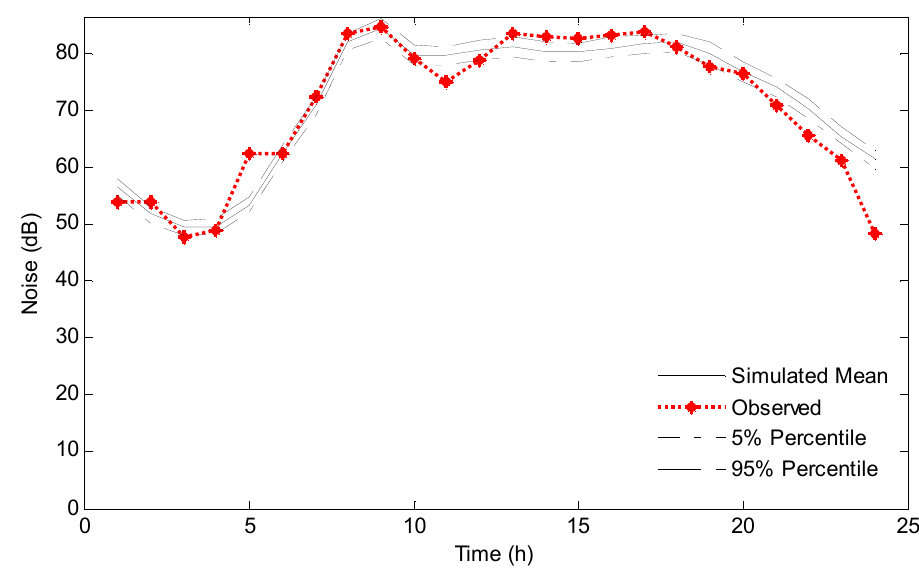
Figure 6. Comparison between the predictions and observations in scenario A 1 . Table 2. Comparison of performance between the nested ensemble filter (NEF) and maximum likelihood estimation (MLE)